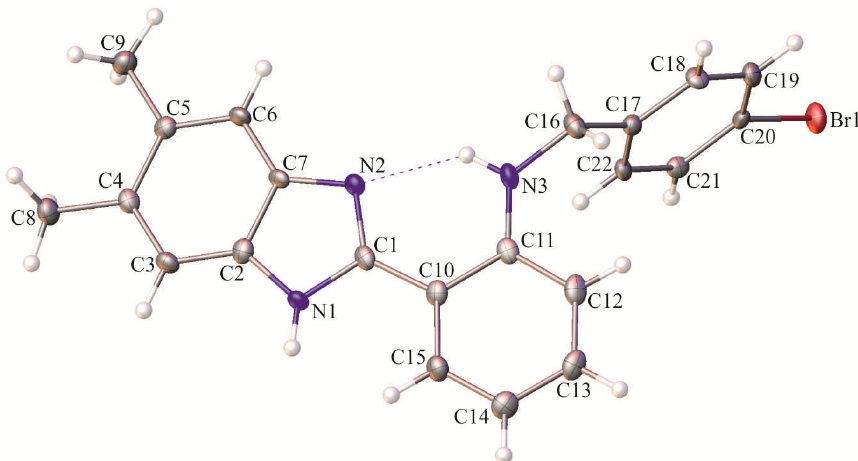
Figure 1. Molecular structure of 15 with crystallographic numbering. Displacement ellipsoids are drawn at the 50% probability level and the H-atoms are shown as small spheres of arbitrary radius. The intramolecular N–H···N hydrogen bond is represented by a dashed line.